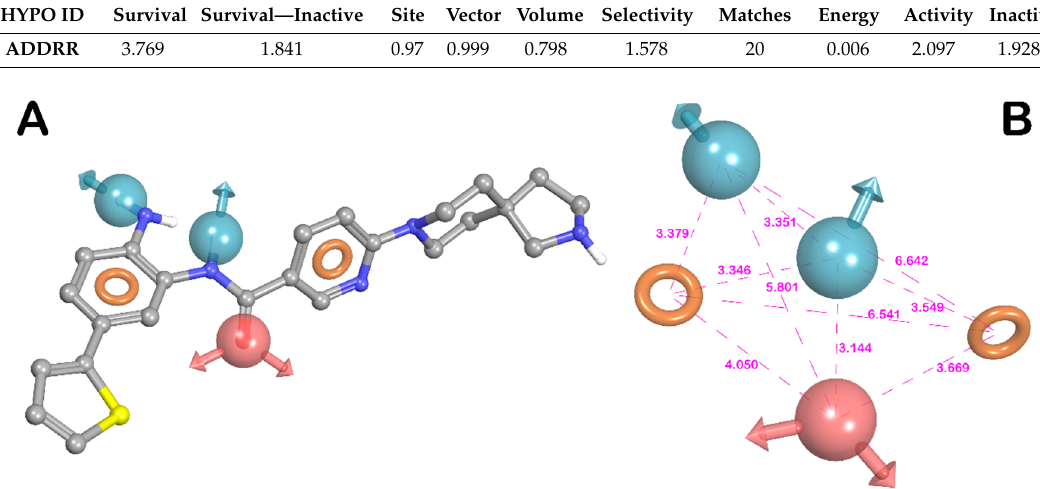
Figure 3. ( A ) Superposition of highly active compound 13 and ADDRR hypothesis. ( B ) ADDRR hypothesis and its inter-feature distances. Features are as follows: H-bond acceptor = A, red vector; H-bond donor = D, blue vectors; aromatic feature = R, orange ring (pictures were generated by means of Maestro software).